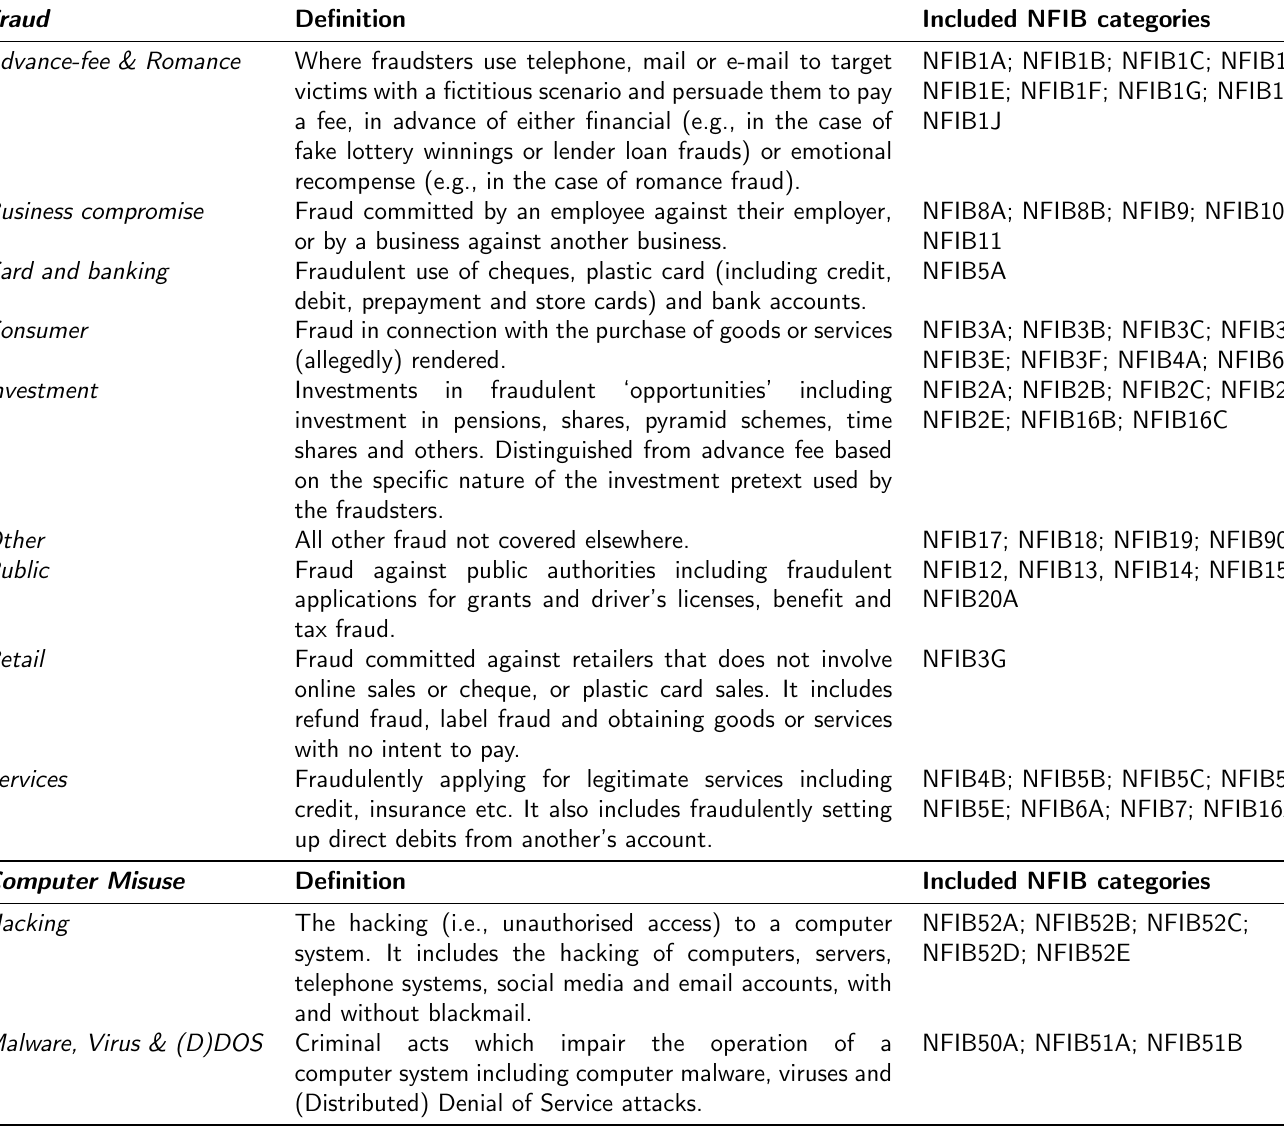
Table 6: Fraud and CM working typology based on NFIB